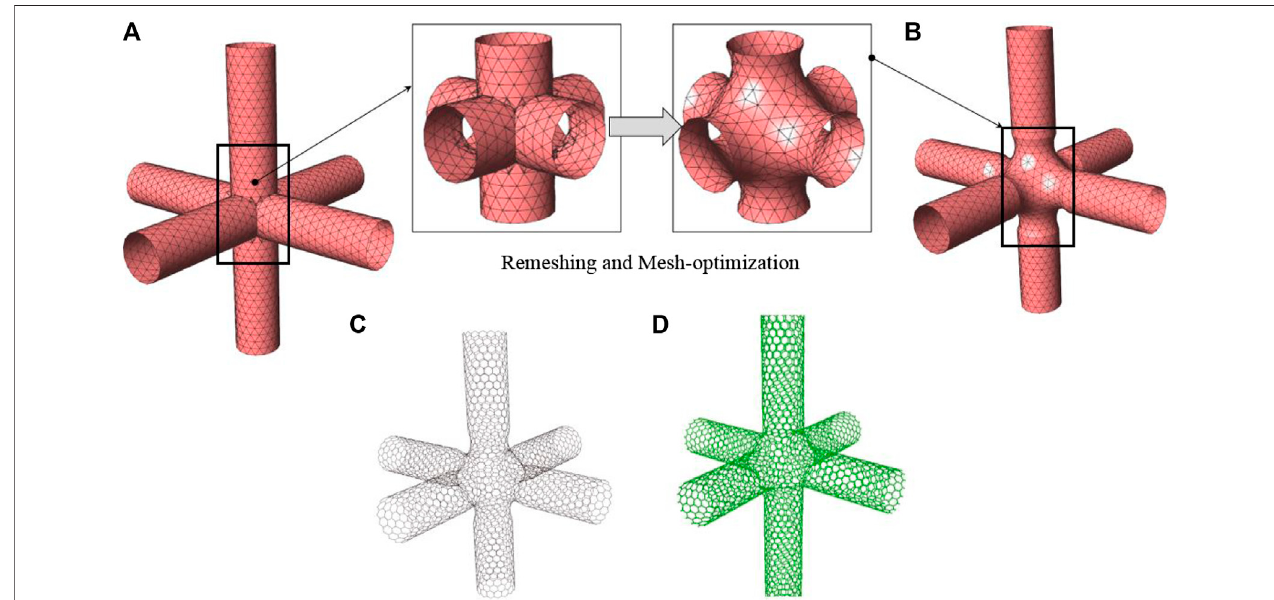
FIGURE5| Procedureforconstructingorthogonal6T-Junction. (A) Dualtriangularmeshof(16,0)nanotubeswithsixdirectlyconnectedarms.Theinsetimagesare beforeandaftersnapshotsofremeshingandmeshoptimizationprocedures. (B) Regulartriangularmeshwithmeshlength2.45Å. (C) Dualgraphoftheregulartriangular mesh with each vertex representing position of carbon atoms. (D) Atomistic model of 6T-Junction after molecular minimization (MM).